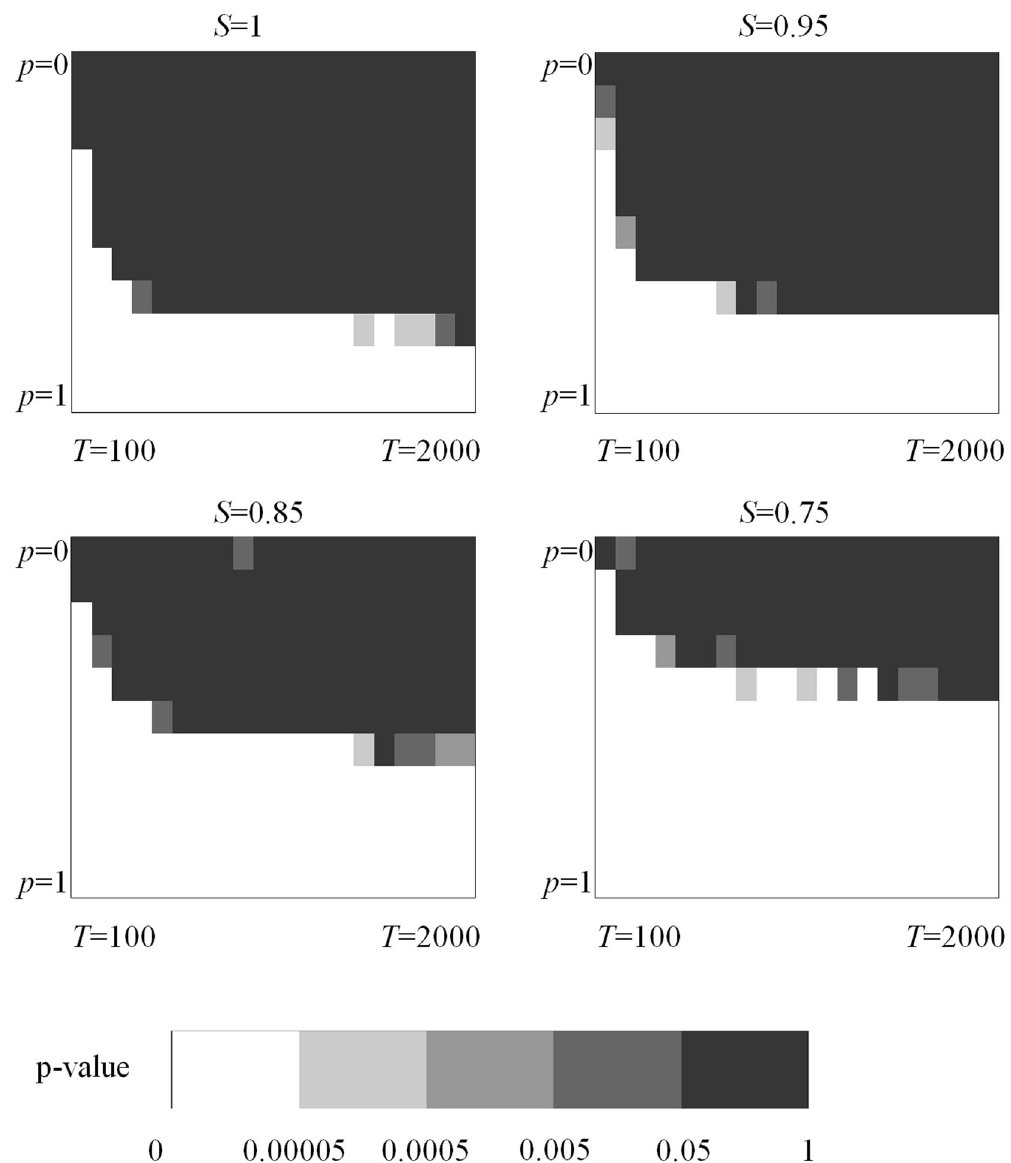
Fig. 13 The effect of the sharing parameter S on model behavior. Explanation of the fi gure is exactly the same as in Fig. 5. In general, more non-black squares appear as S increases, implying solitary behavior is favored. Values for other parameters are: D = 0.002 , M = 1000, Q = 1, S = 1, E =